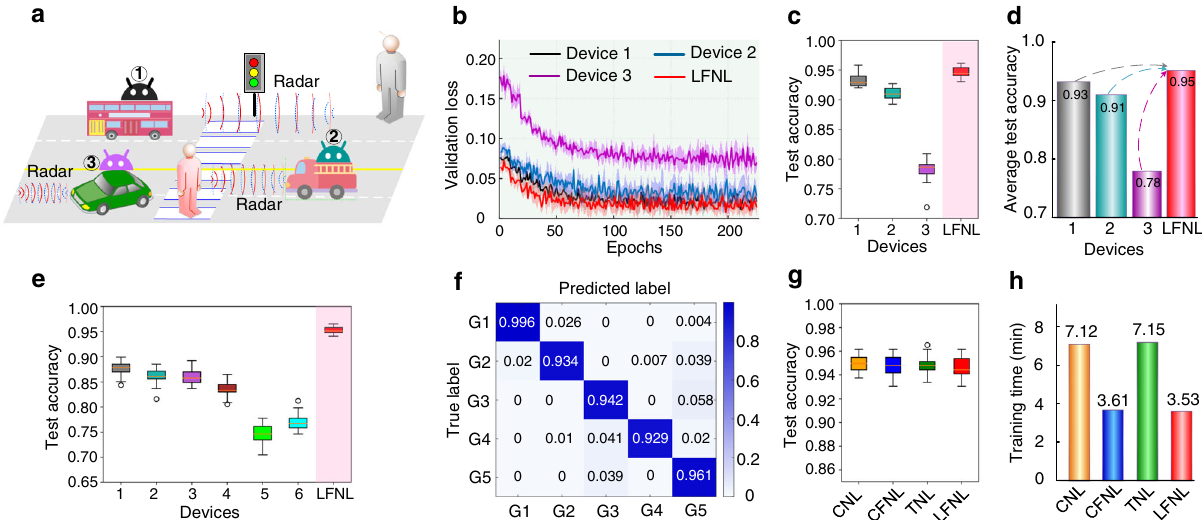
Fig. 4 |LFNLfor radarsignalrecognitionon aroad. a Anexample of radarsignal recognitiononaroad,whichhas fi veradargestureclasses. b Validationlosscurves for three locally training devices and LFNL. c , d Box plots show test accuracy and thehistogramshowstheaveragetestaccuracyperformedforthreelocallytraining devices and LFNL after training. e Illustration of box plots showing test accuracy